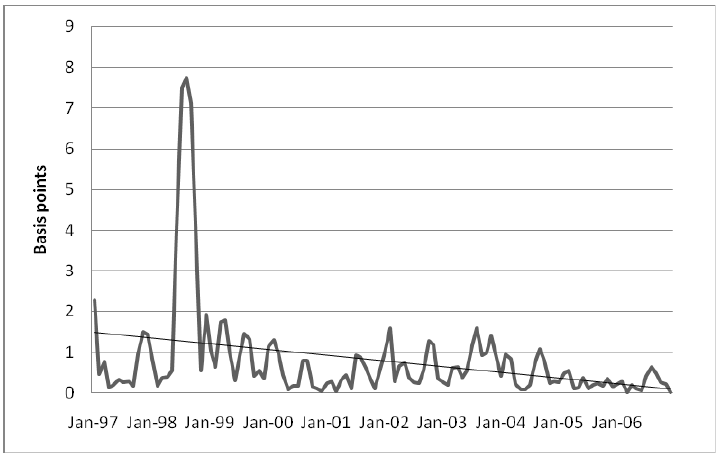
FIGURE 1: JIBAR 3-month-ahead forecast errors (absolute value, in basis points), 1997-2006